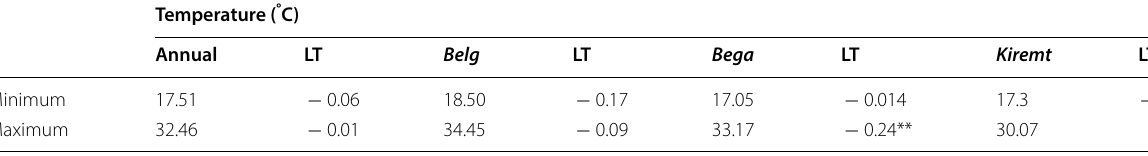
** Significant at 0.01 level; LT linear trend ( ° C /10 yr)